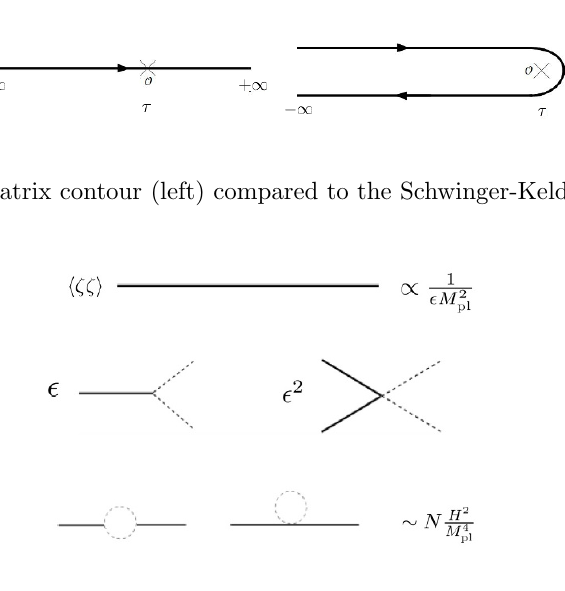
Figure 2 . One loop corrections to h (cid:16)(cid:16) i . Solid lines denote the curvature perturbation propagator, dashed lines denote the (cid:31)